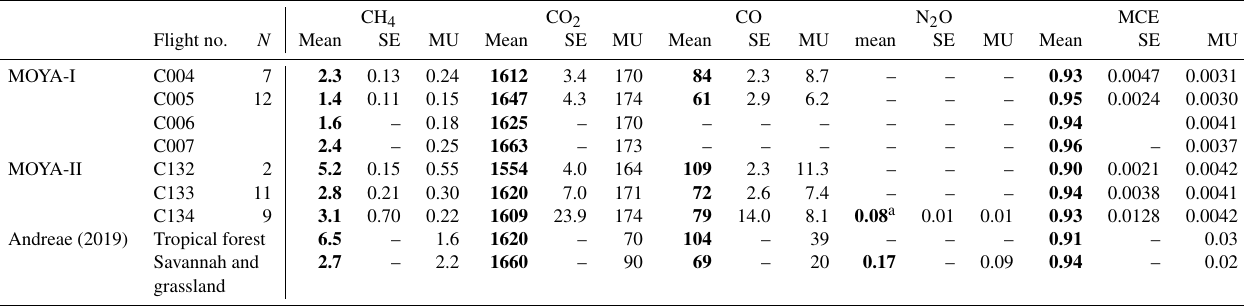
Table 1. Mean CH 4 , CO 2 , N 2 O, and CO EFs and MCE for all MOYA-I (Senegal) and MOYA-II (Uganda) fire sampling flights. Both the standard error on the mean and the mean measurement uncertainty (MU) for EFs and MCEs during each flight for each species are also given. EFs and MCEs compiled from studies of tropical forest and savannah biomass burning by Andreae (2019) are also shown. All EFs are reported in units of grams per kilogram.